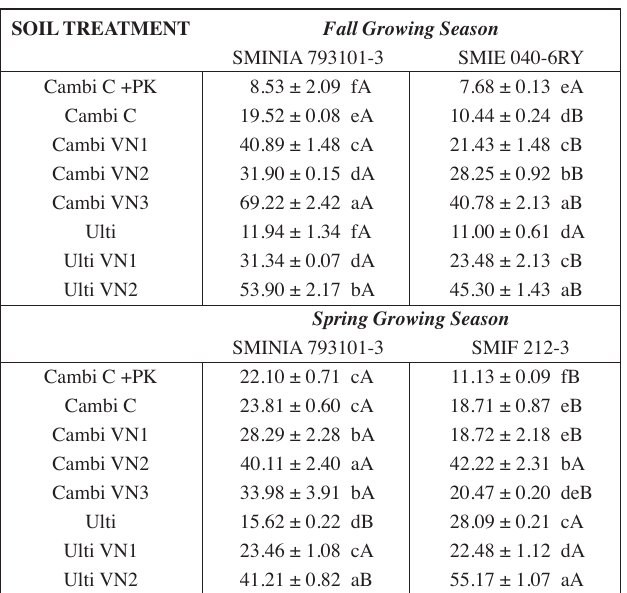
Data represent the mean ± S.D. of six different replicates. Different lowercase letters indicate significant differences between Cu levels in the same potato genotype and collect (p < 0.05). Different capital letters indicate significant differences between potato genotypes at the same Cu level and collect (p < 0.05). TAI* (total Cu concentration in plant tissue / produced tuber Cu